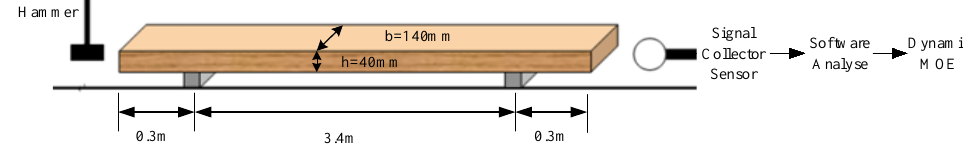
Figure 1. Principle for the determination of the elasticity modulus via FFV ( E FFV ).